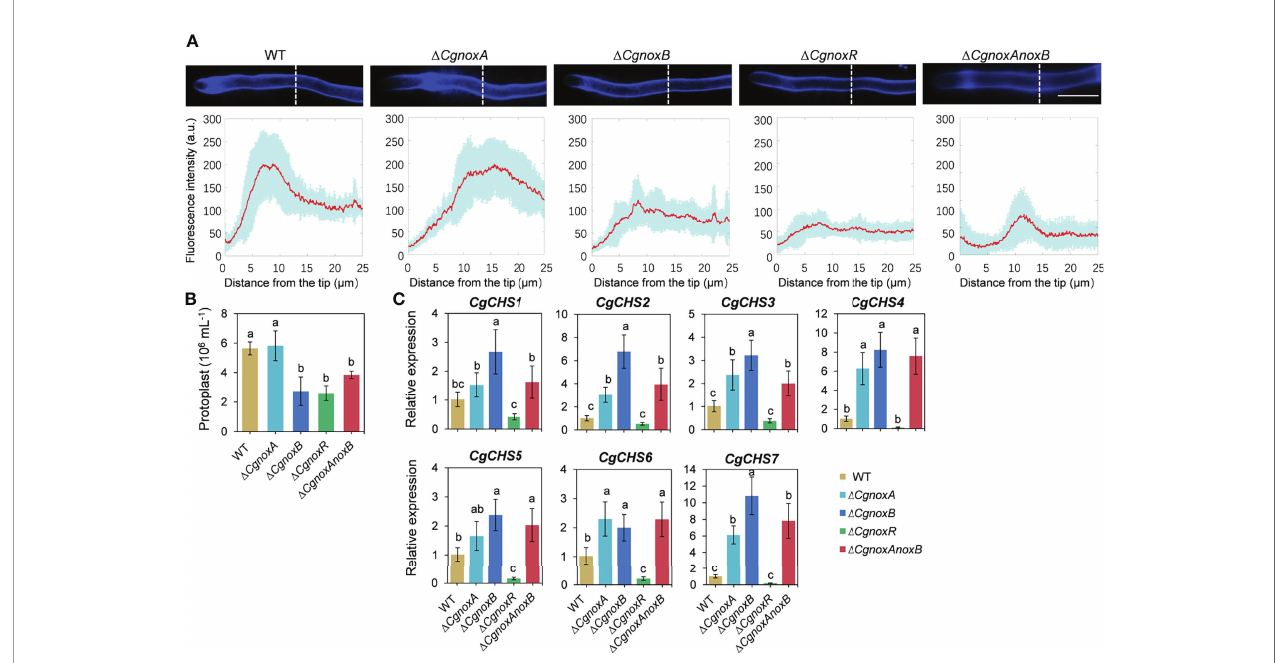
FIGURE 8 | CgNOX regulates cell wall integrity of C. gloeosporioides . (A) CFW staining of hyphal tip from WT, D CgnoxA , D CgnoxB , D CgnoxR , and D CgnoxAnoxB strains. White dotted lines indicate the regions for the measurement. Scale bar = 10 m m. Quantitative measurements of the fl uorescence intensity along the hypha from the tip. The red lines show the average fl uorescence intensity and the blue-shaded regions indicate the SD. At least 10 hyphae were measured for each strain. (B) Bar chart showing frequency of protoplast generation following incubation of mycelium from each strain with lyticase. Bars represent standard deviations (SD). Columns with different letters indicate signi fi cant difference (p < 0.05). (C) Bar charts showing the relative expression level of seven chitin synthase genes in each strain. Bars represent standard deviations (SD). Columns with different letters indicate signi fi cant difference (p <